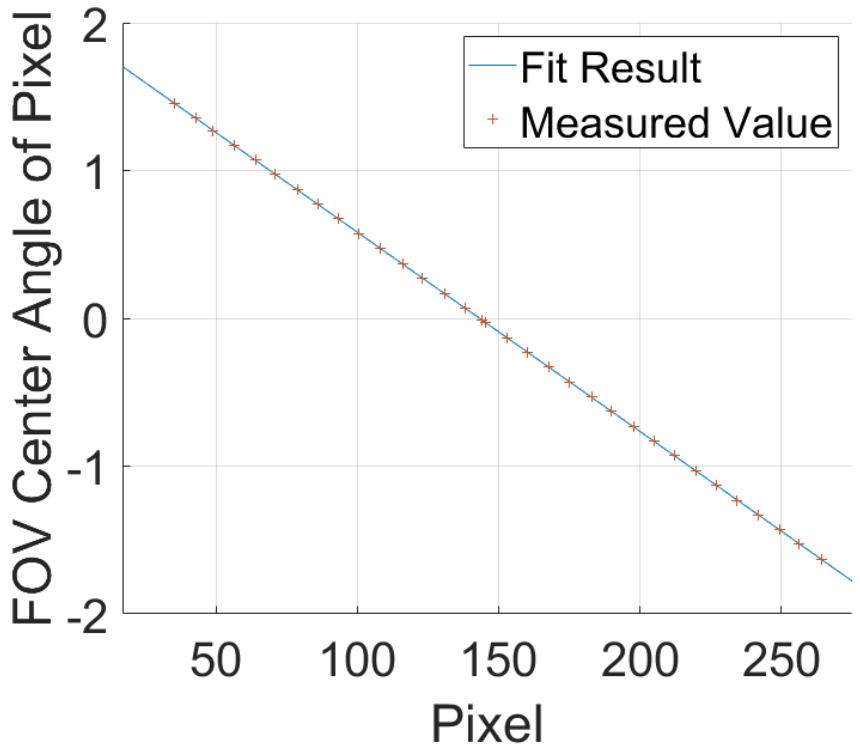
Figure 11. Pixel-space angle that corresponds to the 120th row. Figure 11. Pixel - space angle that corresponds to the 120th row.